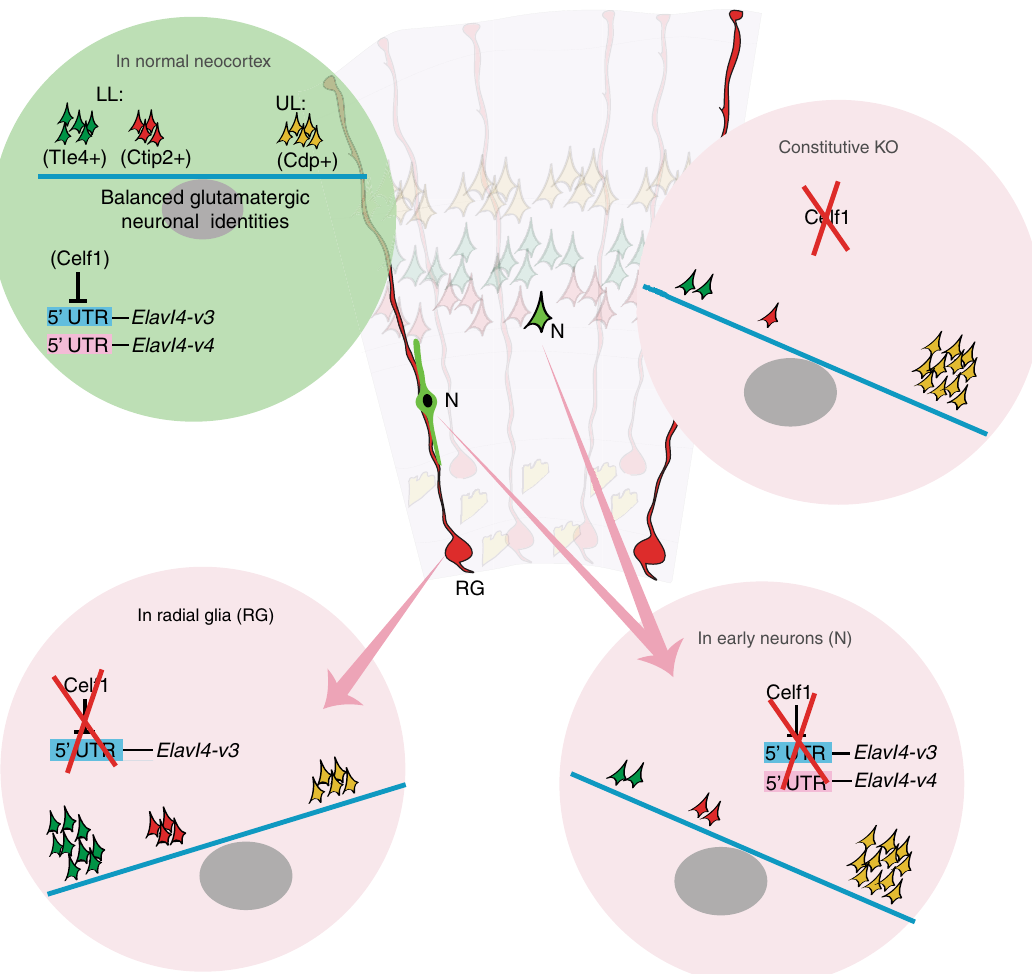
Fig. 10 Summary graphic. Development of glutamatergic neurons is regulated by Celf1 translational repression of Elavl4 through its 5 ʼ